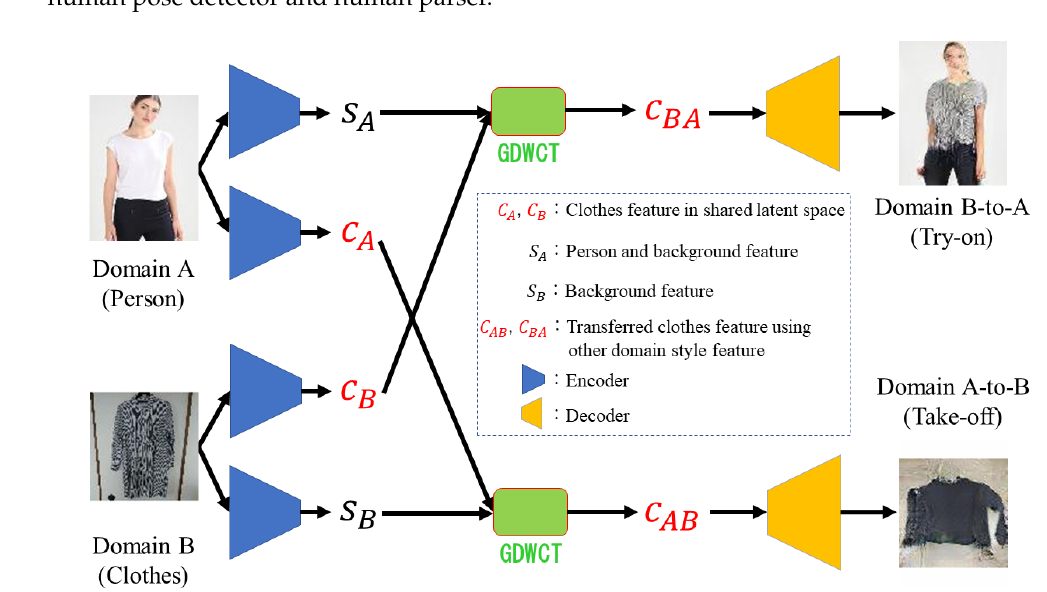
Figure 1. Overview of our system. Firstly, the person image and the clothing image are encoded into the content feature c and the style features s . Note that each domain’s content features c A , c B captures the clothing features, the domain A style feature s A captures the person and background feature and the domain B style feature s B captures the background feature. Next, the exchanged content features c B , c A are combined with the style features of each domain s A , s B by the Group-wise Deep Whitening-and-Coloring Transformation (GDWCT). Finally, the transformed content features c BA , c AB are decoded into their new domain images. Note that this figure is subset of the whole